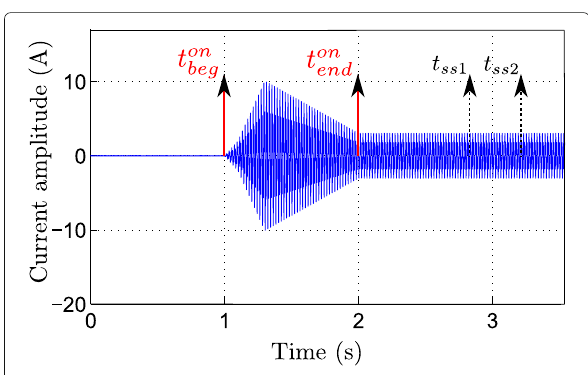
Fig. 4 Output of the High Accuracy NILM Detector (HAND) when applied to a simulated single-appliance signal. HAND outputs the and t on . Blue: current signal. t ss 1 and t ss 2 define the time-instants: t on beg end steady state portion (25 time-cycles long) used for the